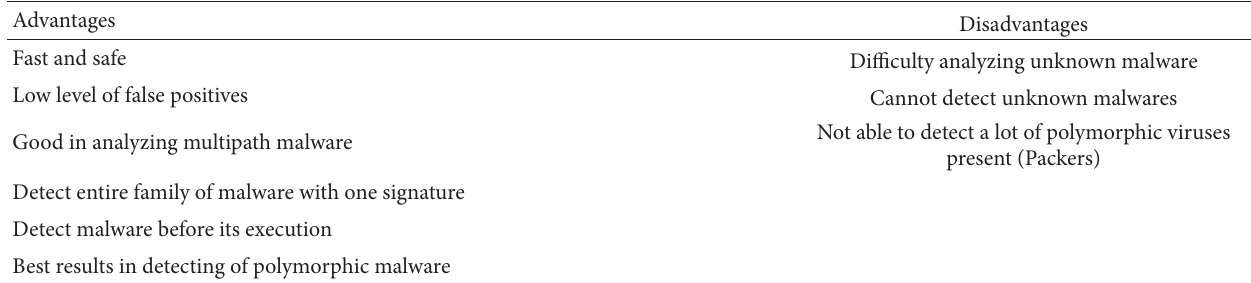
Table 4: Advantages and disadvantages of behavior signature-based technique